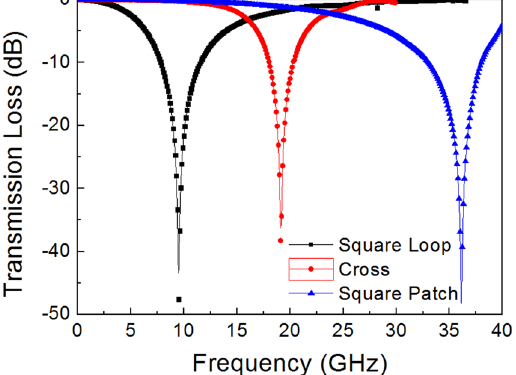
Figure 2. Simulation results of the transmission loss for the three types of FSS (square loop, cross, square patch) standing in free space with the dimensions given in Fig. 1.